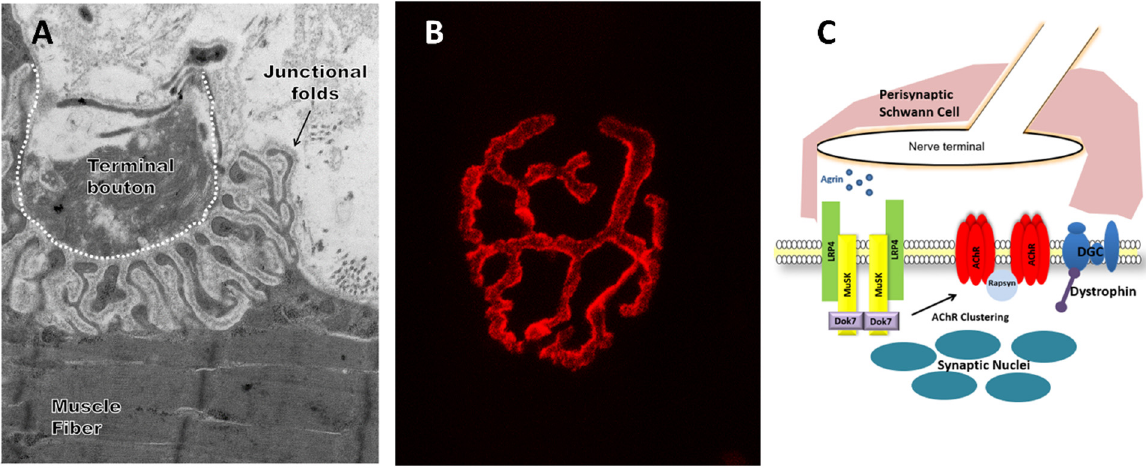
Figure 1. The neuromuscular junction (NMJ) in skeletal muscle. ( A ) Representative electron microscopy image showing ultrastructure of the NMJ. ( B ) Representative confocal microscopy image of fluorescent stain with an acetylcholine receptor binding neurotoxin ( α -Bungarotoxin, BTX, red). ( C ) Illustration describing the components of the NMJ. Perisynaptic Schwann cells are glial regulators of NMJ structure and function. Agrin interacts with lipoprotein receptor-related protein 4 (Lrp4), which activates muscle-specific kinase (MuSK). MuSK, a transmembrane tyrosine kinase, through signaling of Dok-7 and rapsyn, drives acetylcholine receptor (AChR) clustering. Dystrophin and its associated glycoprotein complex (DGC), which is present throughout the muscle fiber membrane, accumulate underneath the post-synaptic